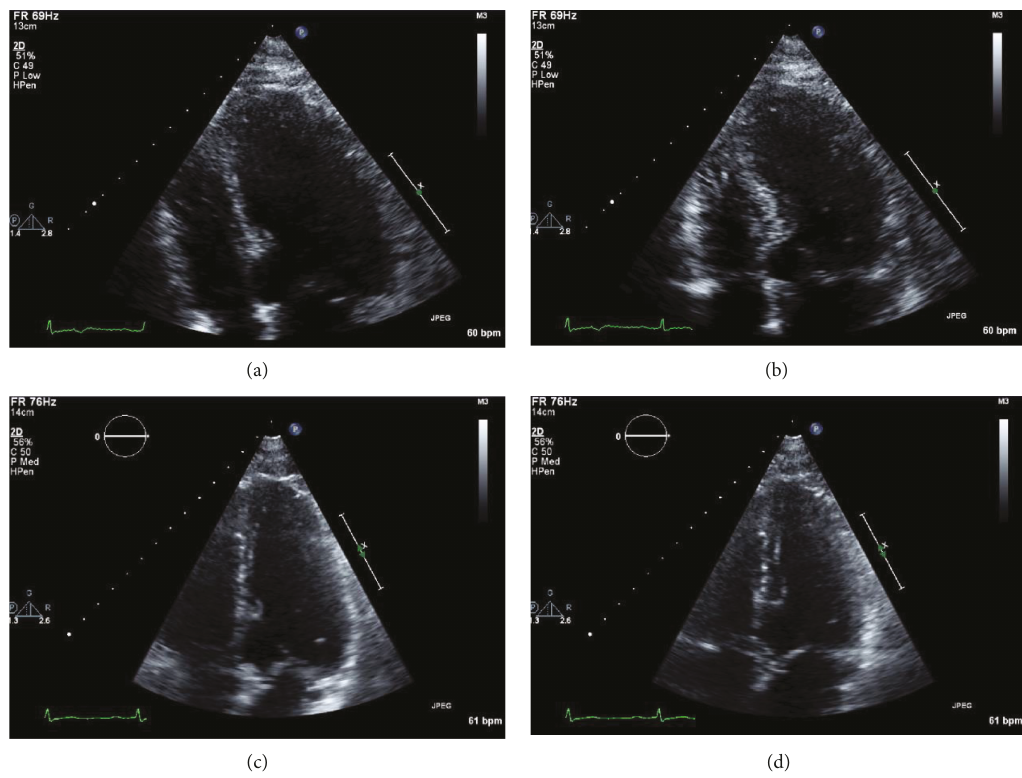
Figure 3: Transthoracic echocardiogram on admission and 6-week follow-up. Apical 4 chamber window at end-diastole (a) and at end- systole (b) showing apical dilatation during acute presentation. (c) Apical 4 chamber window at end-diastole at 6-week follow-up. (d) Apical 4 chamber window at end-systole at 6-week follow-up revealing resolution of apical